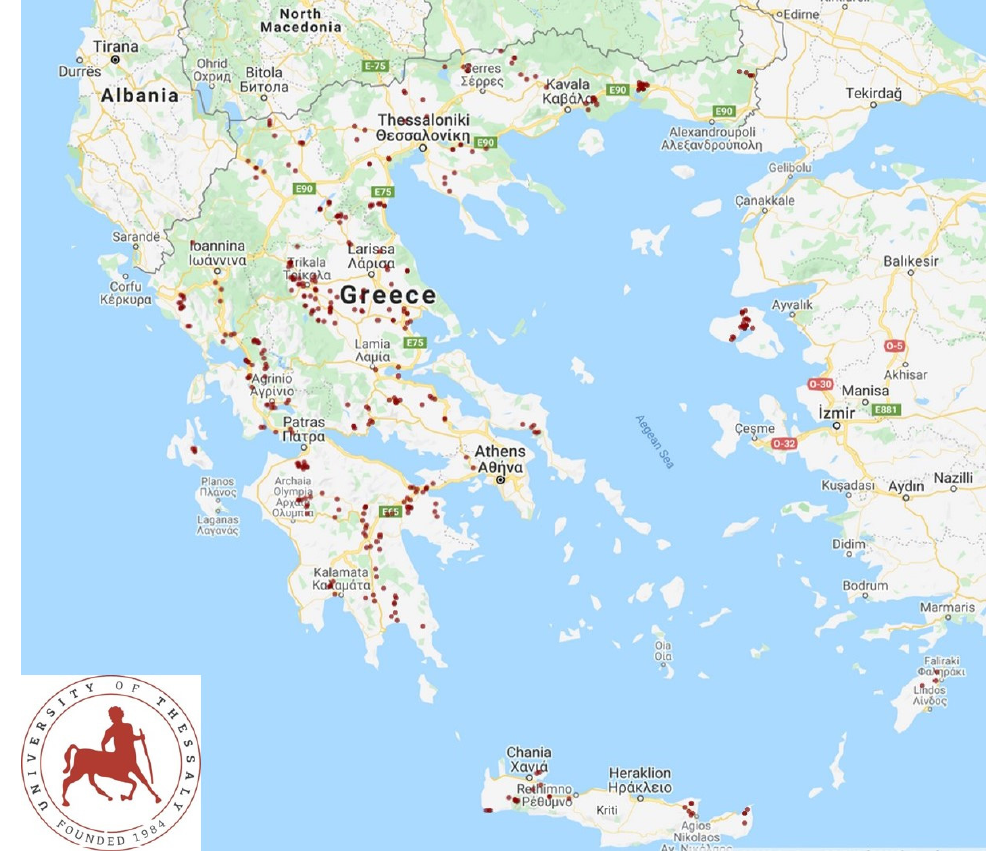
Figure 1. Map of the 444 sheep and goat farms throughout Greece, which were visited for faecal sampling.